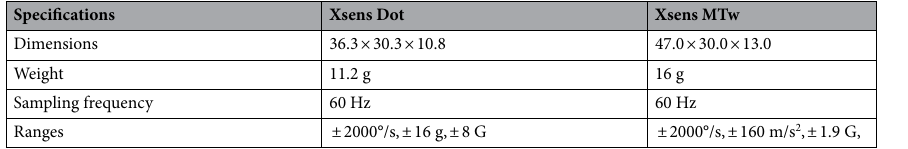
Table 3. Technical specification of the Xsens DOT and the Xsens MTw. Dimensions: length x width x height (mm); Ranges are for: gyroscope, accelerometer, and magnetometer; G-